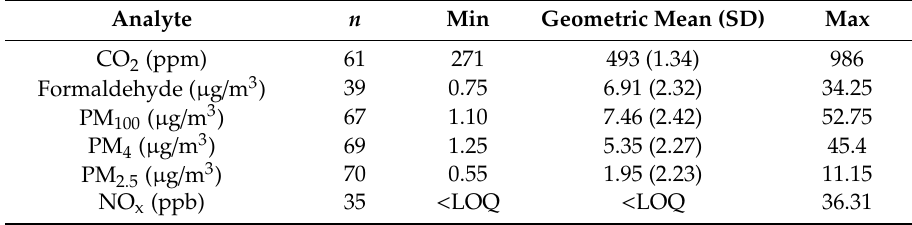
Table 2. Average concentrations of air quality measures across independent sampling campaigns in each building.